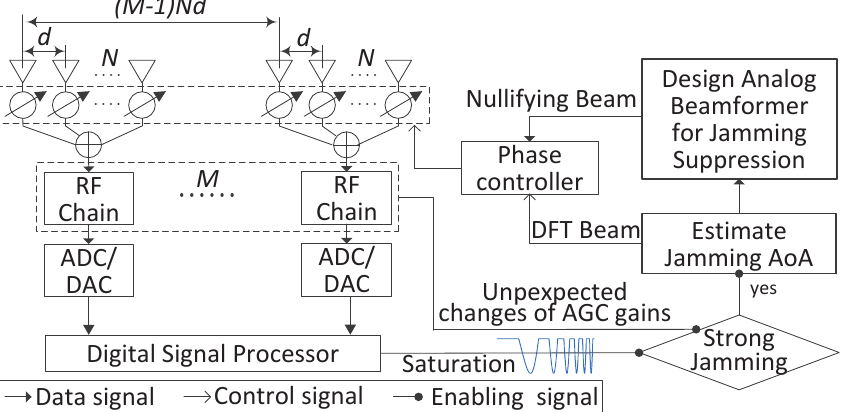
Figure 1. Illustration of the proposed scheme for suppressing strong interference signals based on a uniform linear array with the antenna spacing denoted by d . The array is divided into M subarrays, each having N